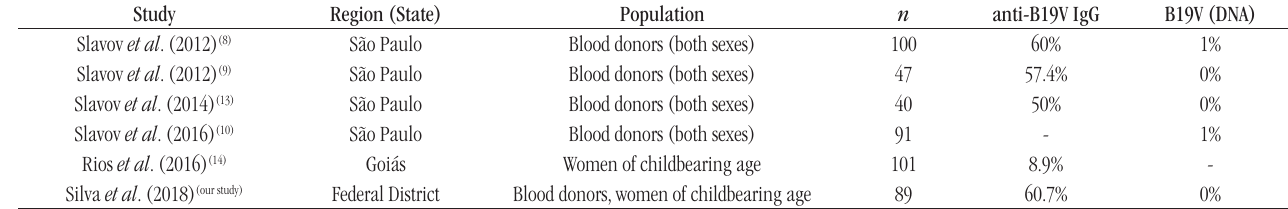
taBLE − Comparison of prevalence of anti-B19V IgG and B19V DNA in studies conducted in Brazil Study Region (State) Population